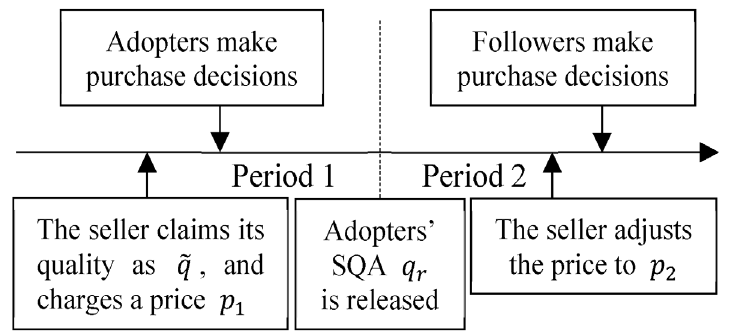
Figure 1. The timing of the game.